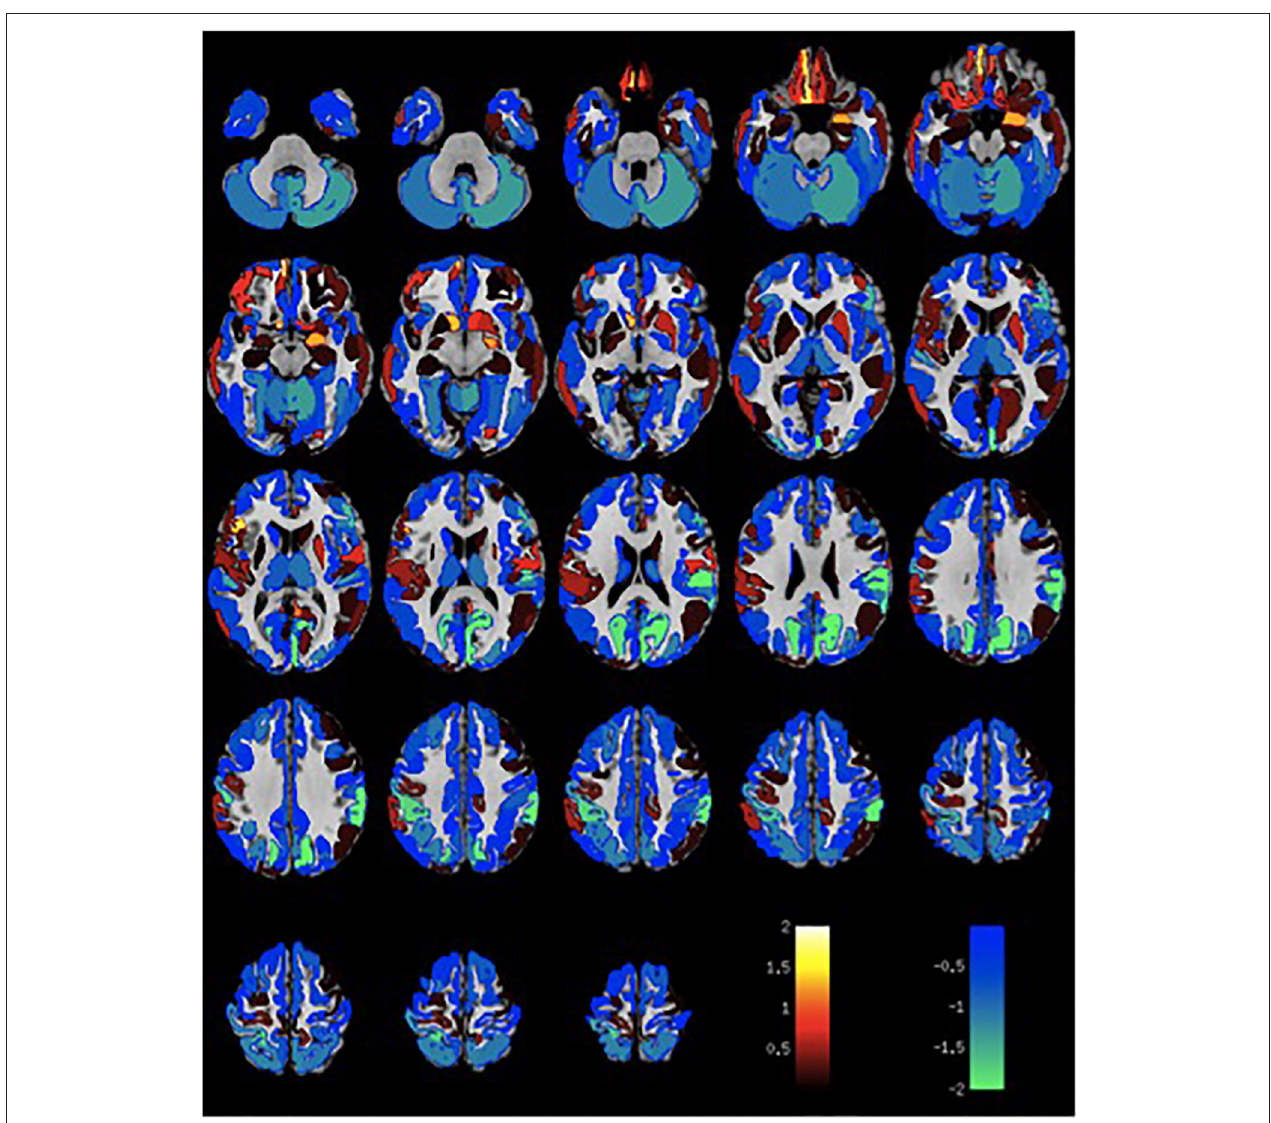
FIGURE 1 | Differences in gray matter volume in patients with visual hallucinations and Parkinson Disease compared to patients with Parkinson Disease without hallucinations or misperceptions. Color scale shows t -statistic for differences in gray matter volume in cortical regions of the Destrieux atlas and 14 subcortical regions with automated FreeSurfer